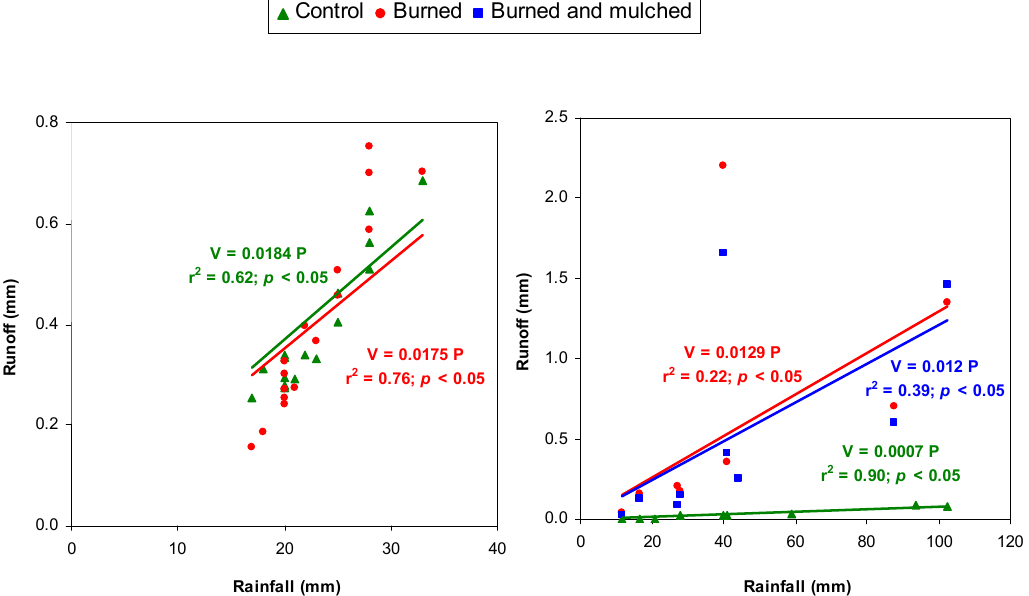
Figure 4. Linear regressions between observed rainfall and runo ff in plots subject to prescribed fire and wildfire (Lezuza, Left , and Li é tor, Right ; Castilla La Mancha, Spain). V is the runo ff volume and P is the rainfall height, while r2 and p are the coe ffi cient of determination and the significance level, respectively. Table 5. Statistics and indexes to evaluate the runo ff prediction capacity of linear regression models in forest plots subject to prescribed fire and wildfire (Lezuza and Li é tor, Castilla La Mancha, Spain). Runo ff Volume Mean Standard